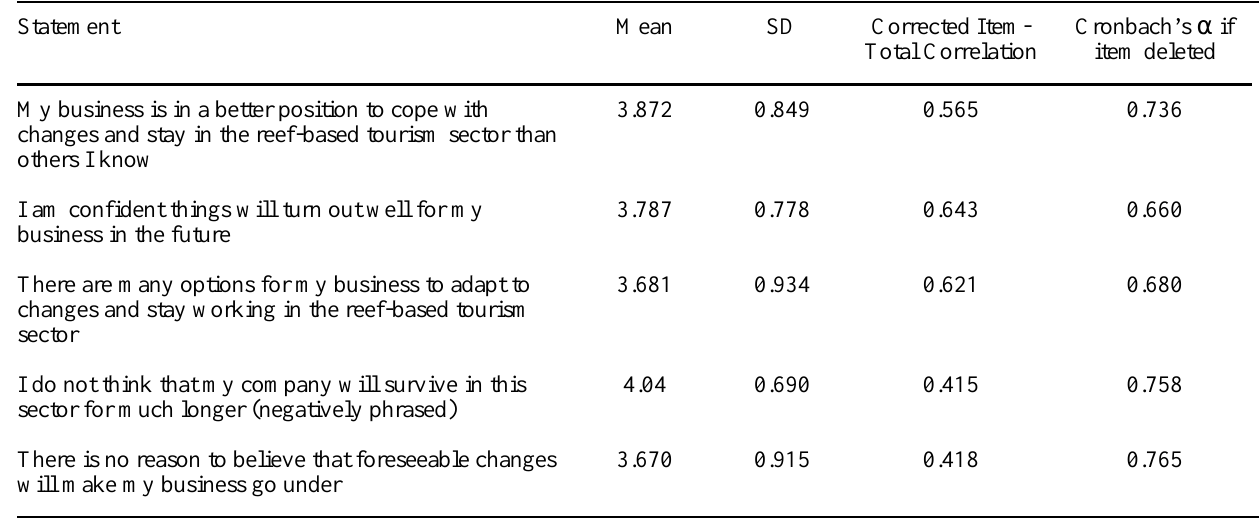
Table 3. Items in the composite scale for social resilience, measured on a 5 point Likert scale (1 = strongly disagree/negative, 5 = strongly agree/positive), Cronbach’s a = 0.764; n =